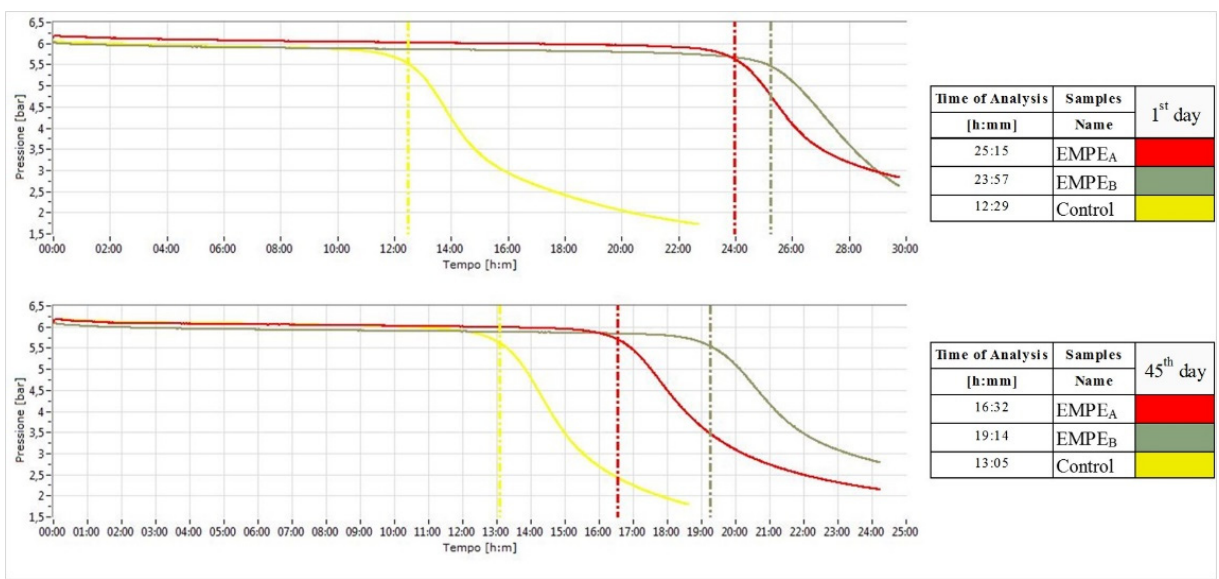
Figure 5 . Oxidation curves at 1st and 45th day of storage: red (EMPE A ), dark grey (EMPE B ), yellow